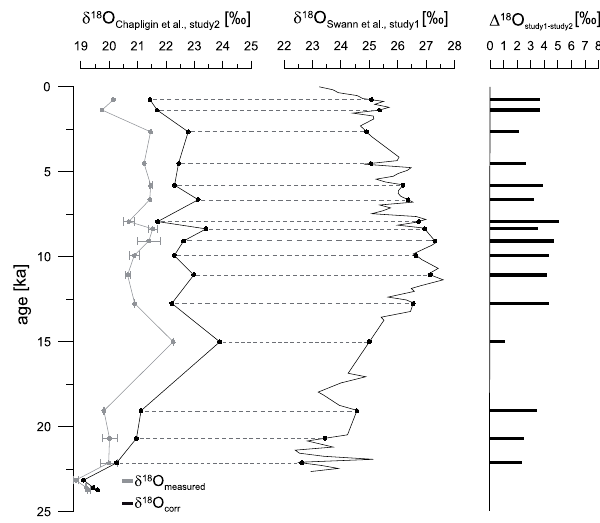
Fig. 6. Both existing studies on δ 18 O diatom -values from Lake El’gygytgyn until the LGM. Left: our study (study2), uncorrected (grey) and corrected (black) δ 18 O record; middle: study by Swann et al. (2010) (study2); right: the resulting offsets between the two